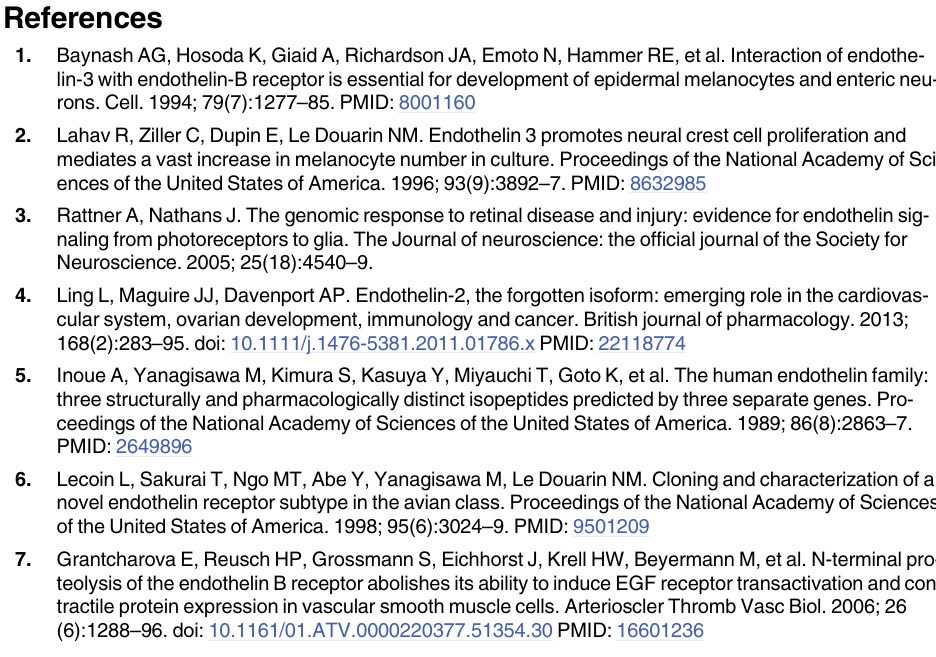
S1 Table. List of reagents and inhibitors. S2 Table. List of primary and secondary antibodies. S3 Table. List of qRT-PCR primer